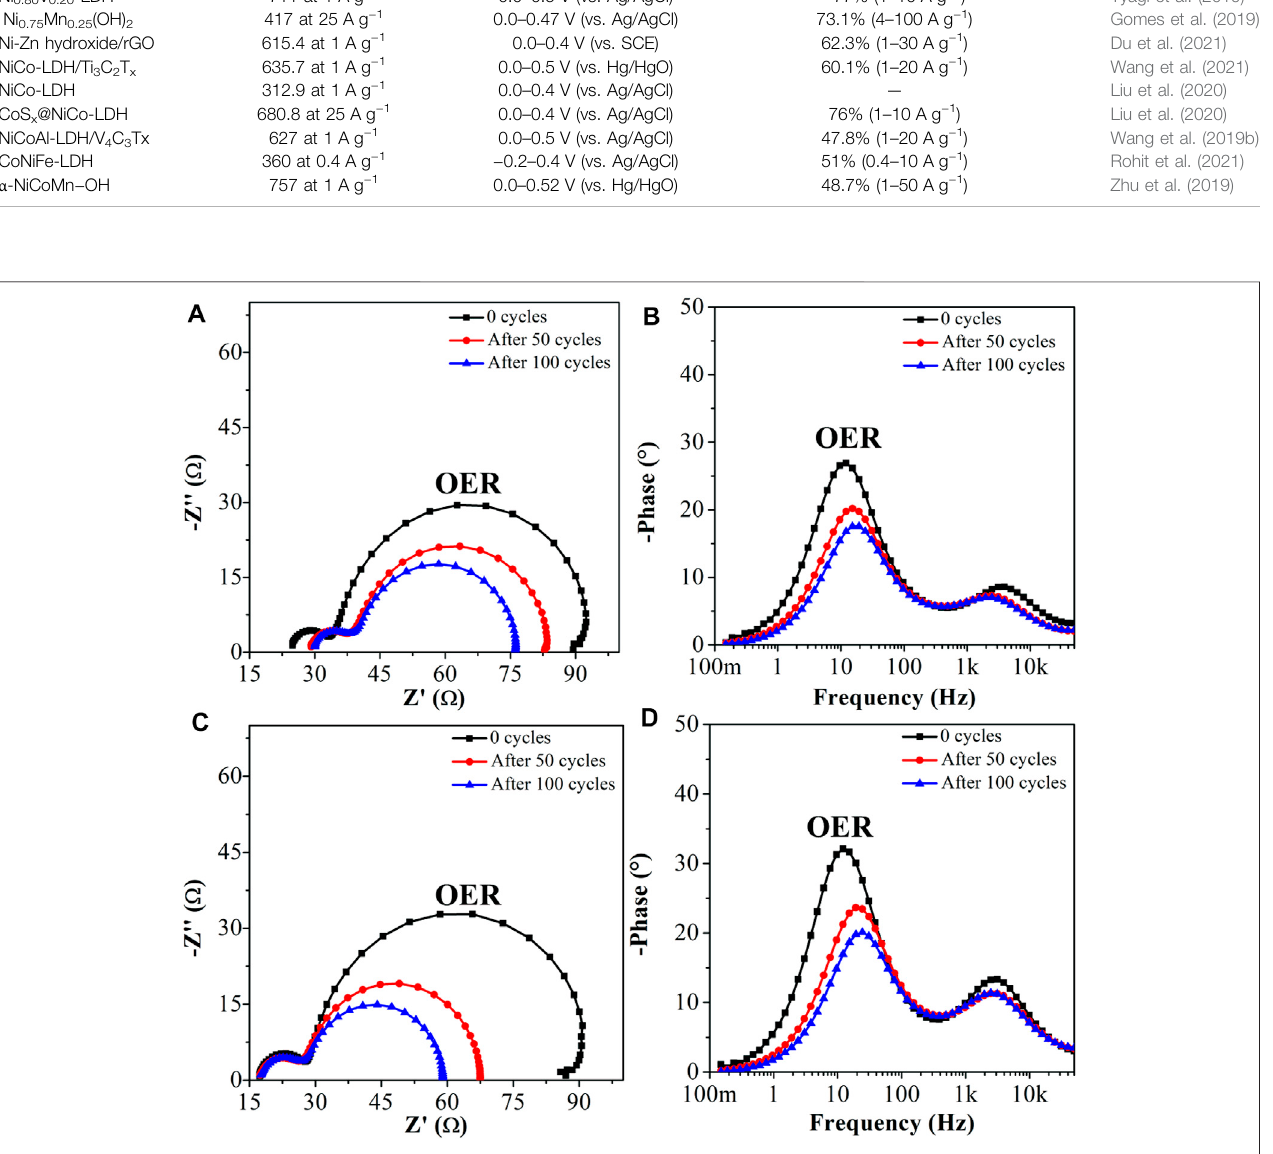
Frontiers in Materials |